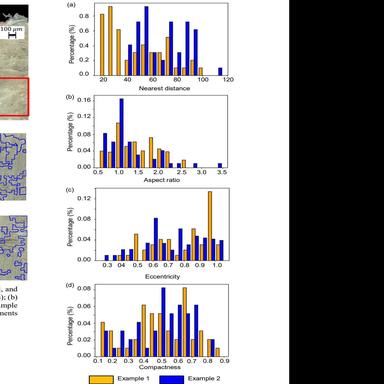
The histogram of physical descriptors for two exemplary blocks: (a) nearest distance, (b) aspect ratio, (c) eccentricity, and (d) compactness. Orange denotes Example 1, and blue represents Example 2.